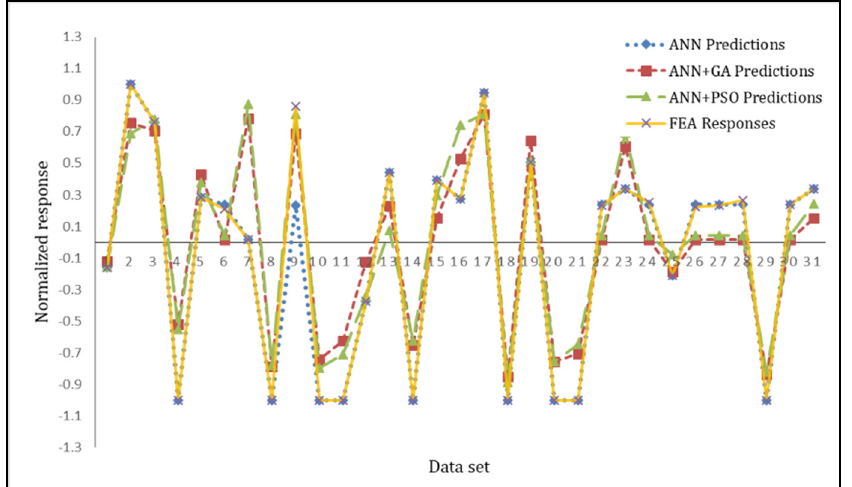
Figure 10. Comparison of normalized neural network and ANOVA prediction values with FEA results. Table 8. Comparison of normalized values predicted by ANOVA, ANN Algorithms, and FEA.